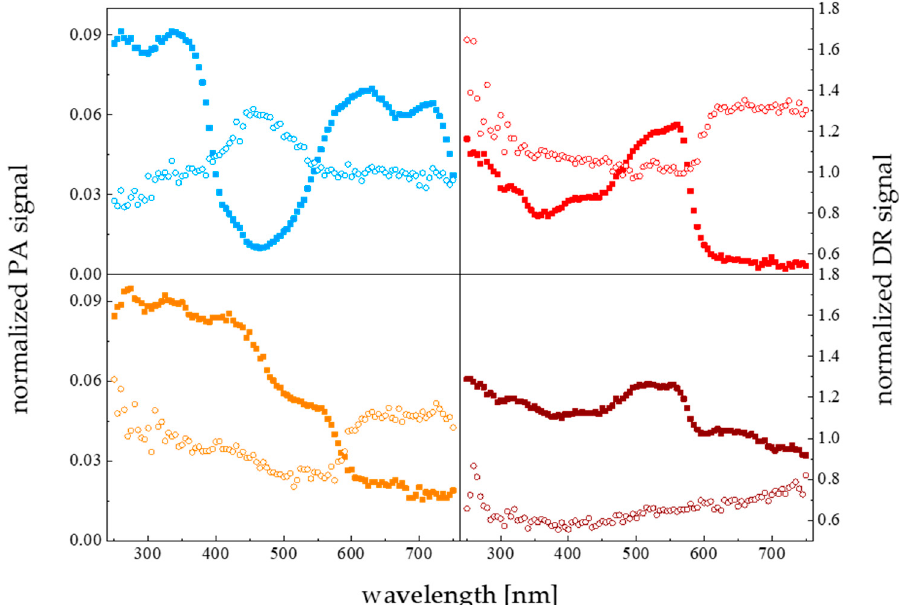
Figure 9. The photoacoustic spectra for solid PVC samples of different colors; sample color corre- sponds to symbol color. PAS data (circles) normalized with respect to carbon black, DR PAS data (filled squares) normalized to powdered quartz; modulation frequency 37 Hz.